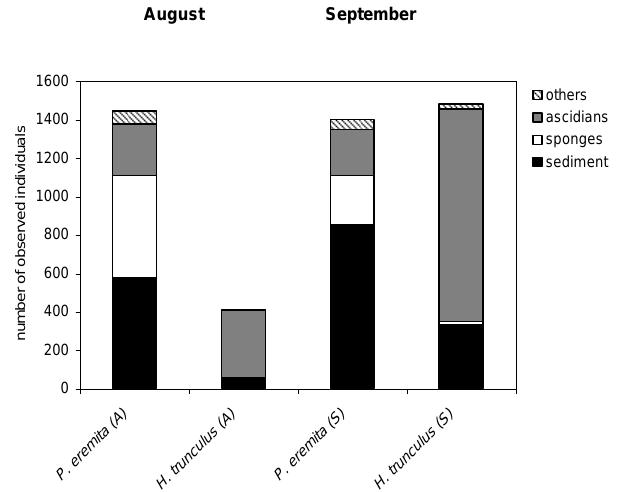
Figure 4: Substrates/prey chosen after anoxia by Paguristes eremita and Hexaplex trunculus in the 869 Fig. 4. Substrates/prey chosen after anoxia by Paguristes eremita August 2009 (A) and September 2009 (S) experiments (“others”: frame or substrate other than 870 and Hexaplex trunculus in the August 2009 (A) and September 2009 sponges, ascidians or sediment). 871 872 (S) experiments (“others”: frame or substrate other than sponges, 873 ascidians or